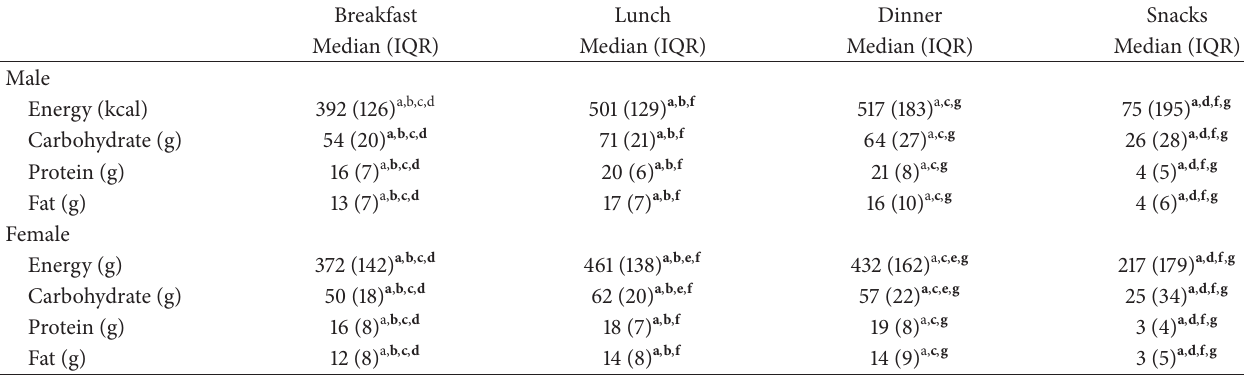
Table 6: Differences of macronutrient and energy intakes for 3 main meals (breakfast, lunch, and dinner). Breakfast Lunch Dinner Snacks